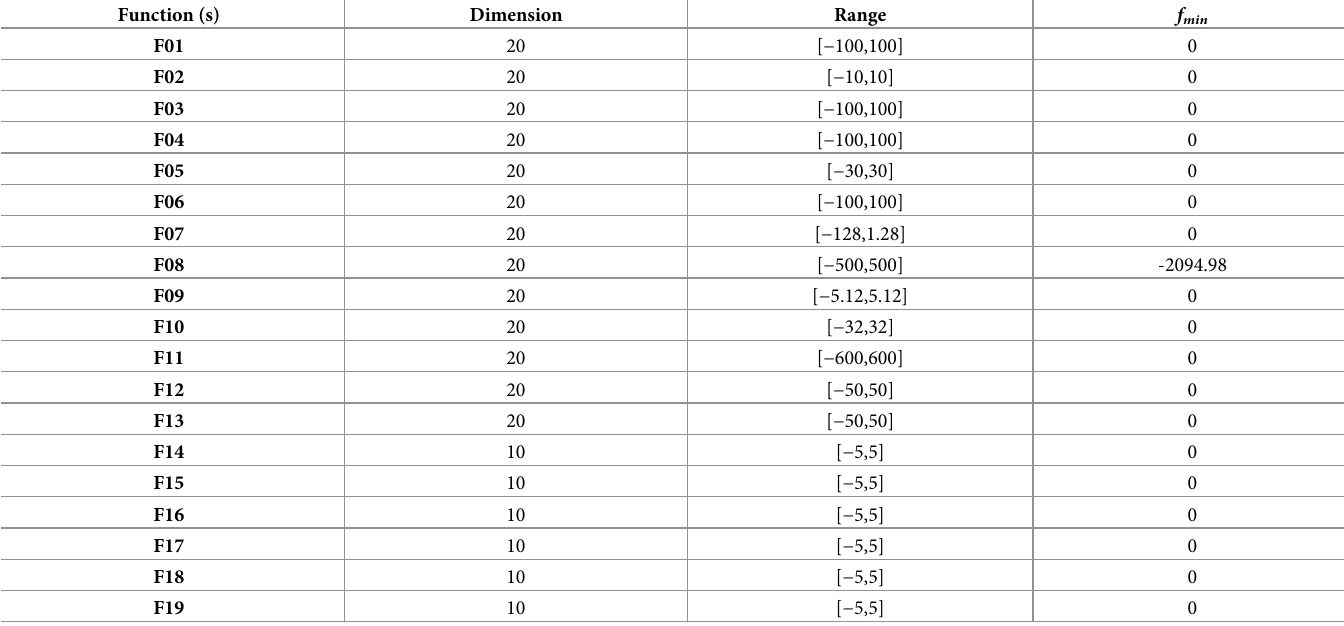
Table 3. Properties of the benchmark